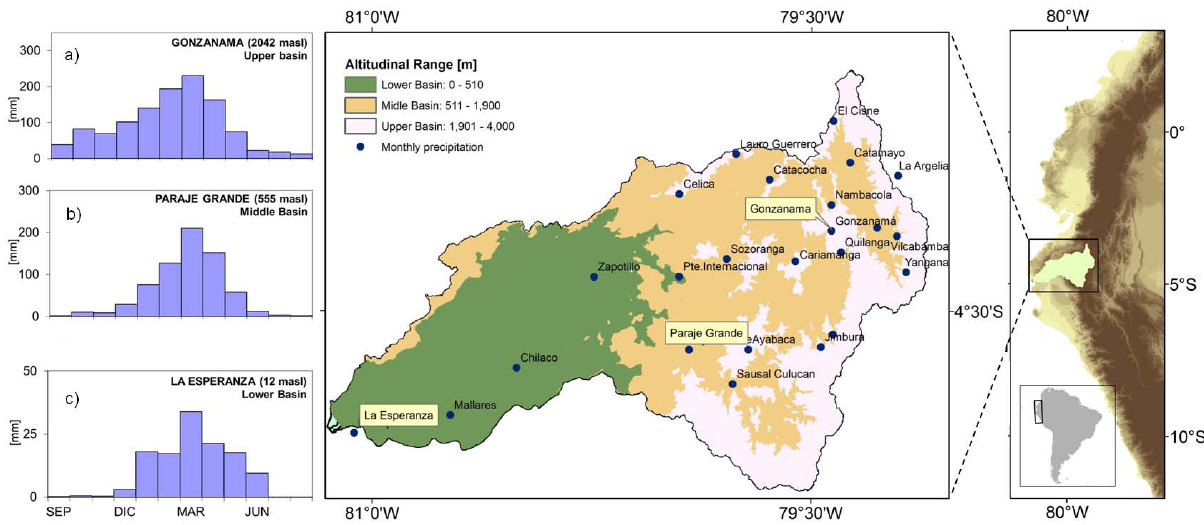
Fig. 1. (Left) Median monthly precipitation at (a) Gonzanama (2042ma.s.l.), (b) Paraje Grande (555ma.s.l.) and (c) La Esper- anza (12ma.s.l.). (Centre) Selected stations with monthly precipitation data in three different elevation ranges ( < 510, 511–1900 and > 1901ma.s.l.) in the Catamayo-Chira basin. (Right) Catchment location in the Pacific-Andean